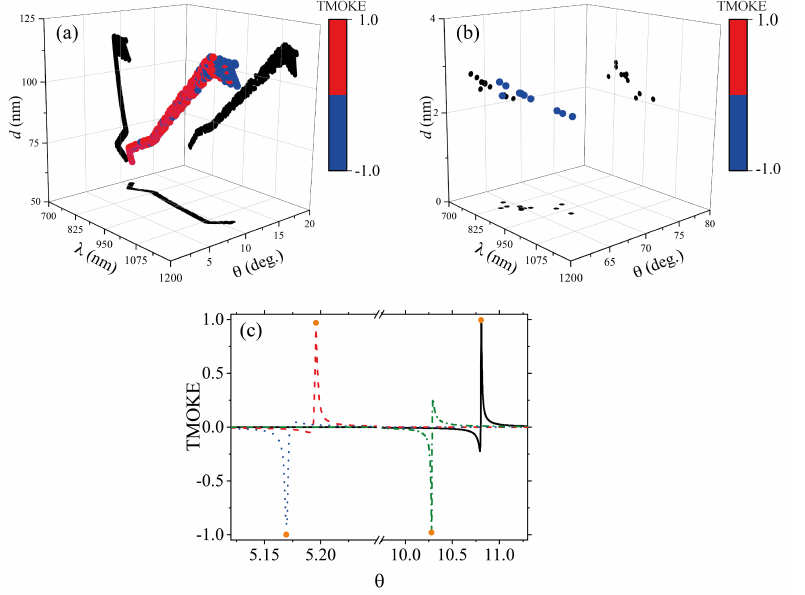
Figure 5. Multidimensional plot of GA optimized ε -near-zero magnetophotonic nanostructures for giant TMOKE amplitudes. Each point in the 3D plot represents a set of values ( λ , d , θ ,TMOKE), where the color scale is used to represent the fourth dimension on the graph (corresponding to the TMOKE value). For visualization purposes, the results are shown for ( a ) 0 ◦ ≤ θ ≤ 20 ◦ and ( b ) 60 ◦ ≤ θ ≤ 80 ◦ . For eye-guide, we plotted projections along the ( d , θ ), ( λ , θ ) and ( λ , d ) planes with solid black dots. A comparison of the GA results ( λ , d , θ ) with the exact numerical results from the SMM is shown in ( c ) for the set of values (818.83 nm, 71.998 nm, 10.807 degree), (830.72 nm, 307.49 nm, 5.196 degree), (846.58 nm, 315.5 nm, 5.1696 degree), and (873.33 nm, 81.563 nm, 10.279 degree), whereas the solid, dashed, dotted, and dash-dotted lines, represent the exact SMM calculations for the corresponding structures. All the results in this figure were obtained for the system with the Co-substrate. Analogous results (not shown here) were obtained for the system with the Fe-substrate.